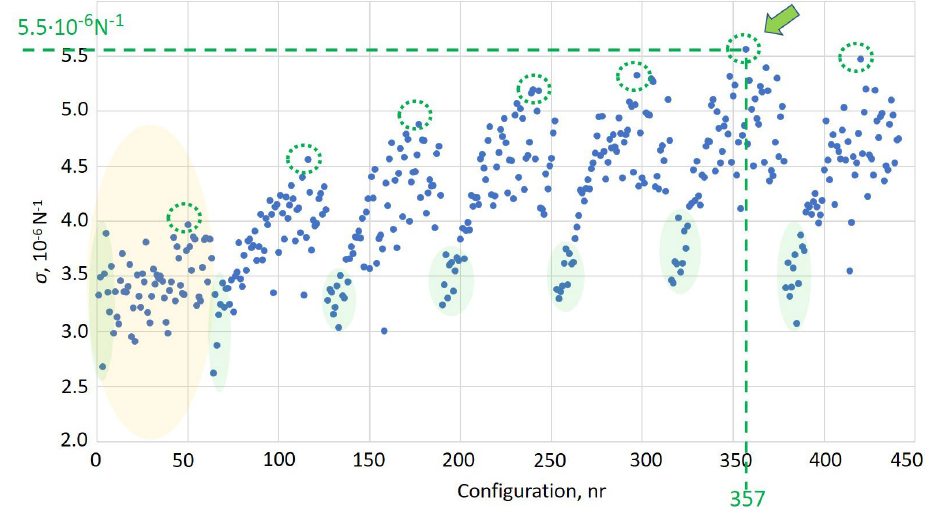
Fig. 6. Correlation between technical benefit and mixing configuration type using two criteria, fluid velocity and power consumption. Best scenario is indicated by the arrow and corresponds to configuration 357 with α1 = 75°, α2 = 60°, h1 = 2 m, h2 = 3.8